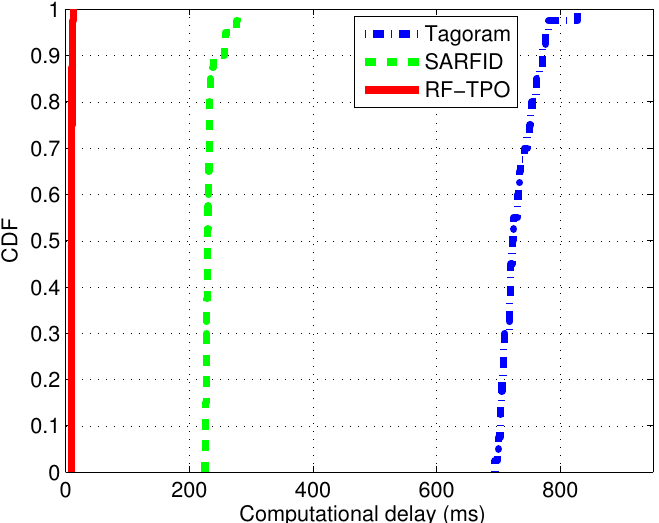
Figure 14. Computational delay comparison among different